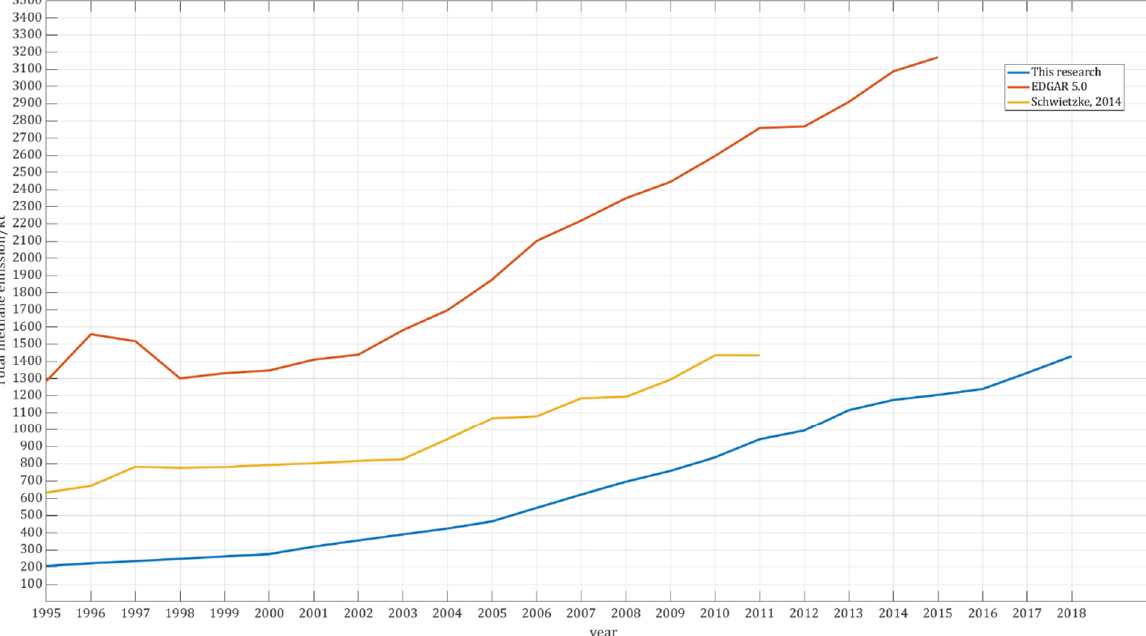
Figure 3. Comparison of different research.